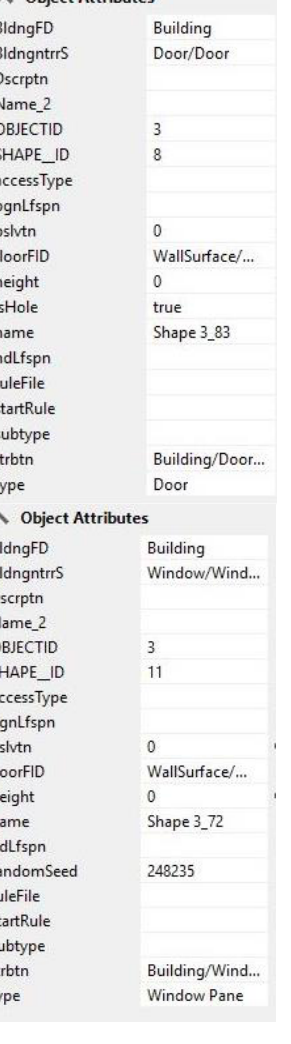
Figure 1 7 : Visualization of the model in the FZK